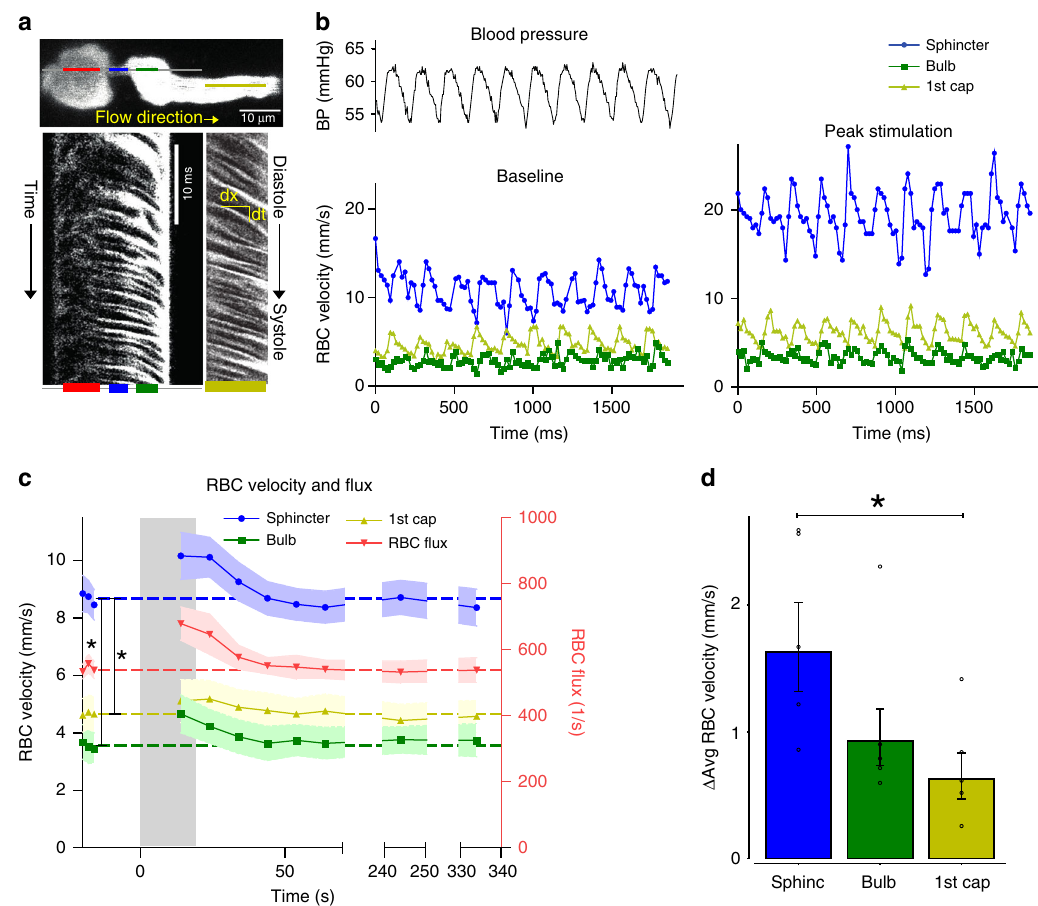
Fig. 4 Red blood cell velocity and fl ux at the sphincter. a Resonance scanning allows for rapid repetitive line-scans in a single z-plane (upper panel). In the resulting space – time maps (lower panel), individual cells appear in black with an angle proportional to the cell velocity. Red, blue, green, and yellow lines indicate the regions of the line-scans derived from the PA, sphincter, bulb, and fi rst order capillary ( fi rst order capillaries were mostly scanned in consecutive experiments). b Fluctuations in femoral artery blood pressure (left upper panel) and RBC velocity (left lower panel) correlated. During whisker pad stimulation (right panel), RBC velocity increased. c Time series of RBC velocities and fl ux during whisker pad stimulation. RBC velocity at the precapillary sphincter was signi fi cantly higher than the bulb and fi rst order capillary at baseline and peaked around 10 s after stimulation before returning to baseline. d Summary of the difference between maximal and baseline RBC velocity during whisker stimulation. In d , the LME analysis was performed